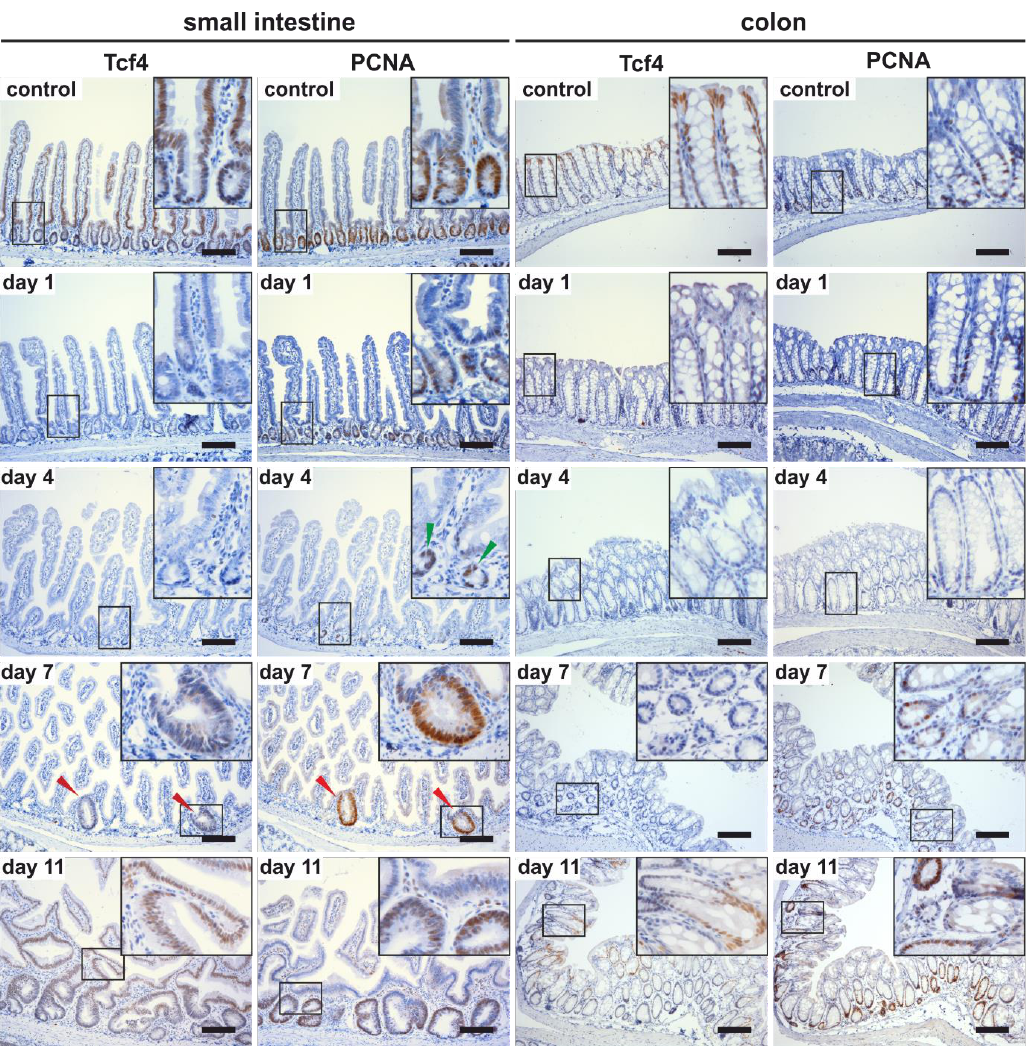
Figure 3. Absence of proliferating crypt cells in the adult Tcf4-deficient intestine. Immunodetection of Tcf4 and PCNA protein in the small intestine and colon of Tcf4 flox5/flox5 Villin-CreERT2 mice at indicated time points after tamoxifen administration. Notice the presence of a small number of residual crypts containing PCNA-positive proliferating cells in the small intestine at day 4 after tamoxifen administration (green arrowheads); at day 7, hyperplastic crypts expressing Tcf4 and PCNA are formed (red arrowheads). In the colon epithelium, Tcf4- and PCNA-positive staining is partially restored at day 11. Specimens were counterstained with hematoxylin. Magnified images are shown in the insets. Scale bar: 0.3 mm.